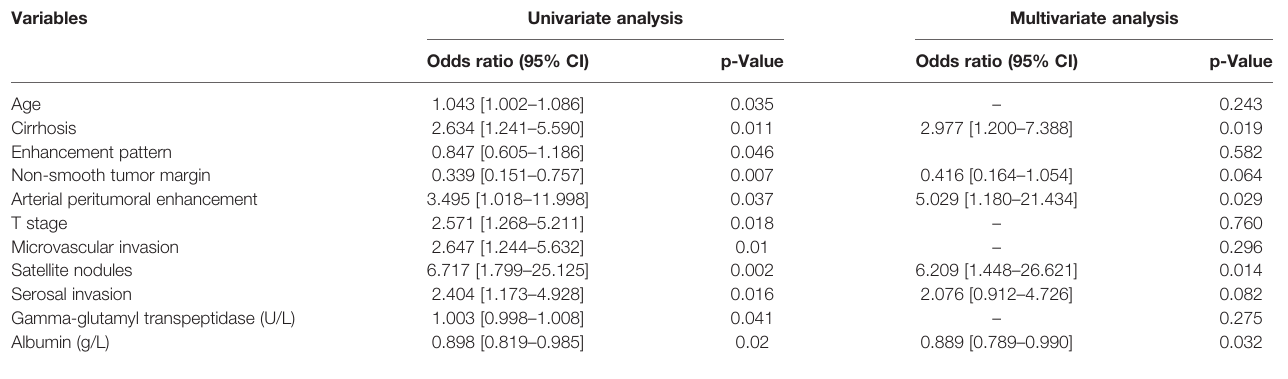
TABLE 2 | Univariate and multivariate analyses for early recurrence in the training